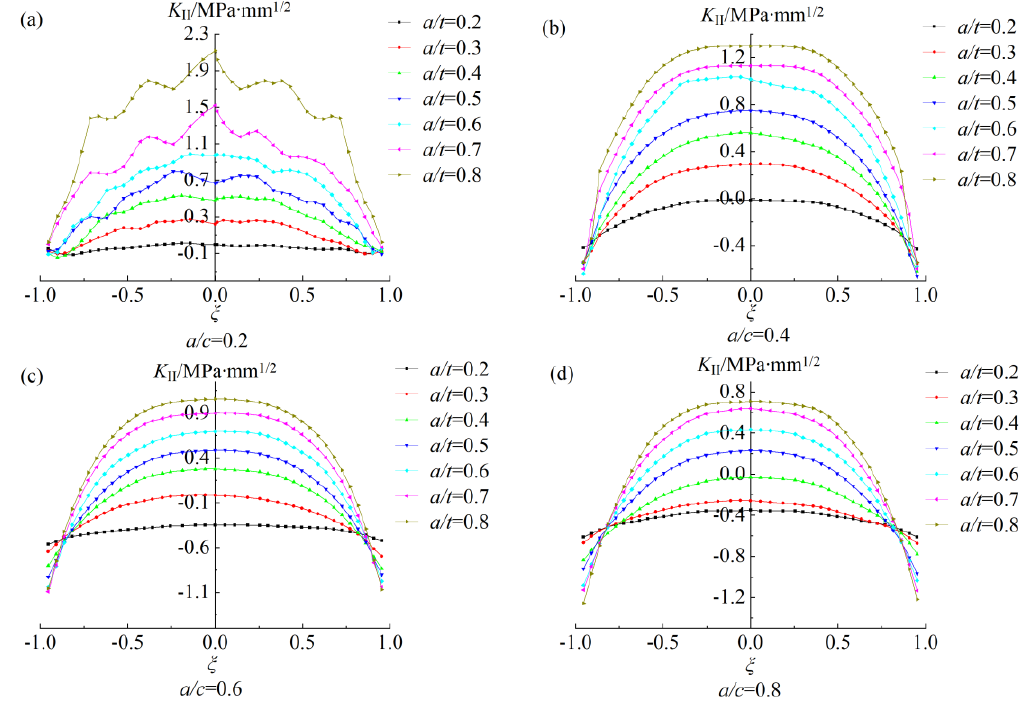
Figure 7. Distribution of type II SIF ( K II ) at the front of the semi-elliptical crack on the neck of the ampoule bottle. ( a ) a / c = 0.2. ( b ) a / c = 0.4. ( c ) a / c = 0.6. ( d ) a / c = 0.8.